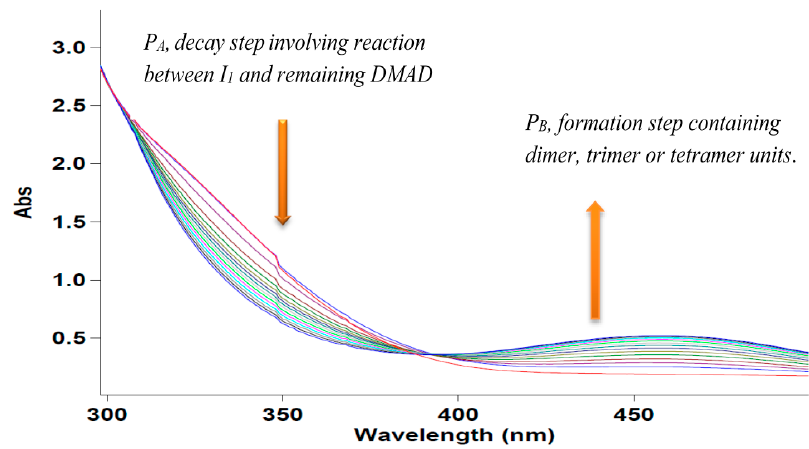
Figure 3. UV spectra of a binary mixture with TPP (2.50 × 0 − 3 M) and DMAD (5.00 × 10 − 3 M). The downward direction of the arrow indicates Part A or the decay step involving the reaction between I 1 and the remaining DMAD. The upward direction of the arrow indicates the formation of the product in Part B that is tentatively presumed to contain polymeric oligomers (e.g., dimer, trimer; Scheme 1).